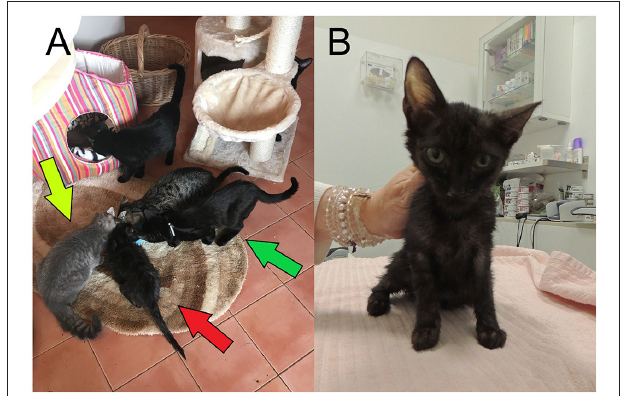
FIGURE 1 | (A) Patient at age 6 months (red arrow), two of his litter mates (green arrow), and another cat of the same age (yellow arrow). (B) Patient at age 6 months in